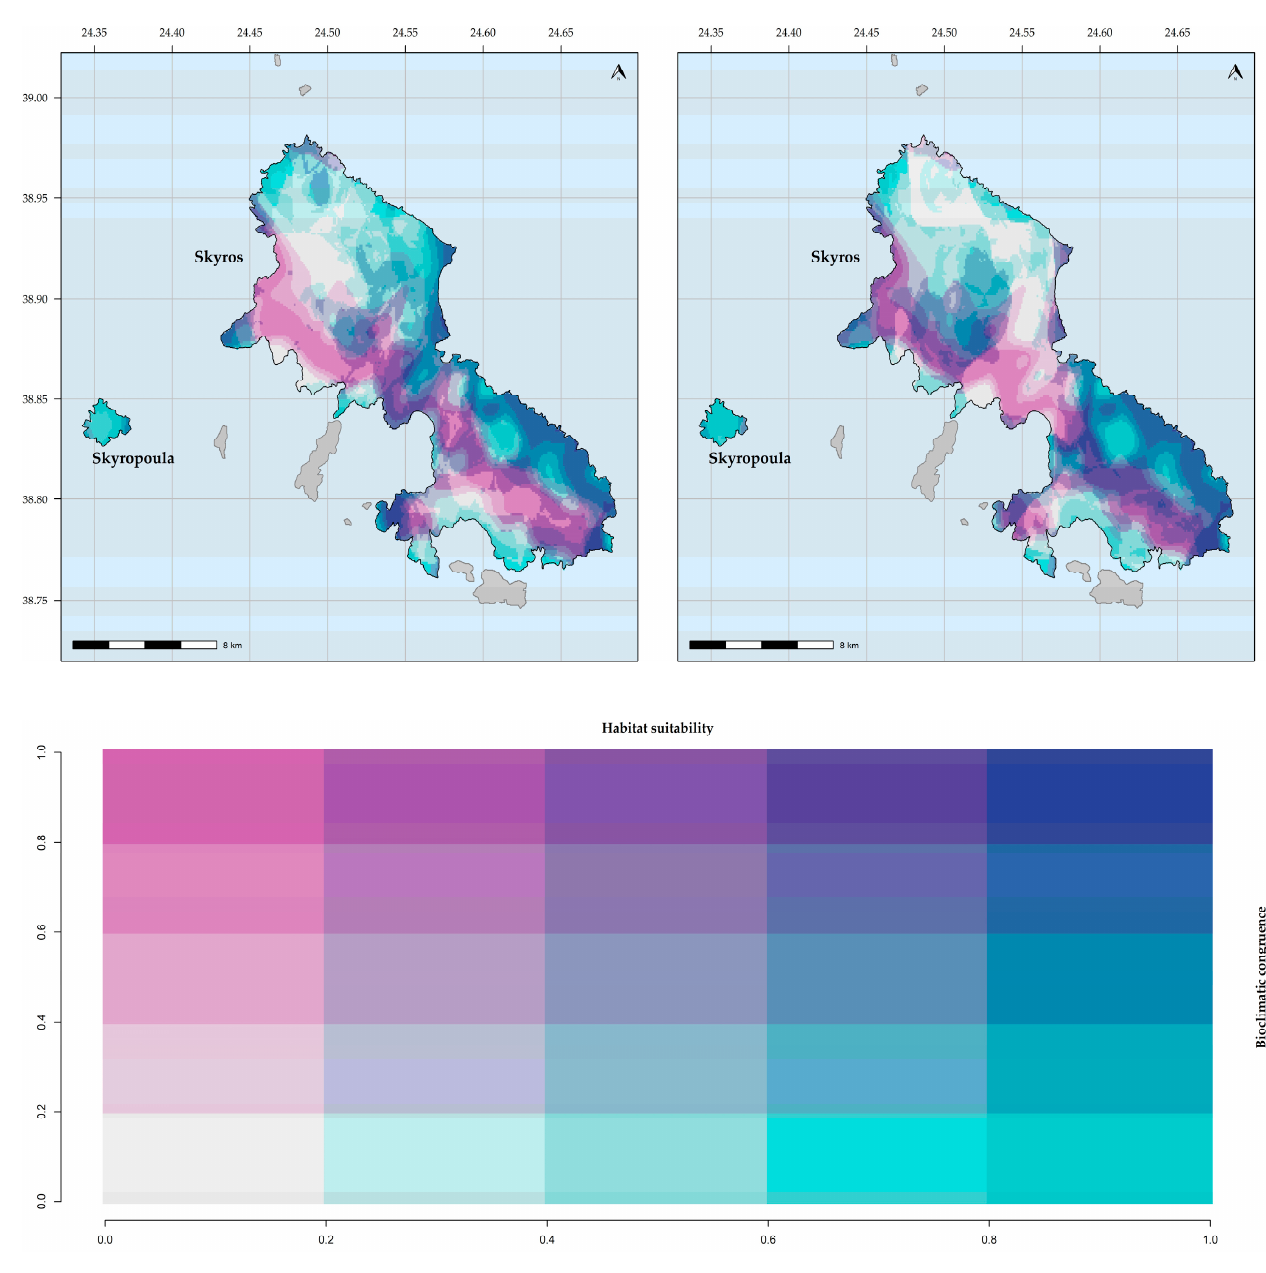
Figure 4. Bioclimatic consistency maps for Aethionema retsina . From left to right: based on WorldClim; based on CHELSA.